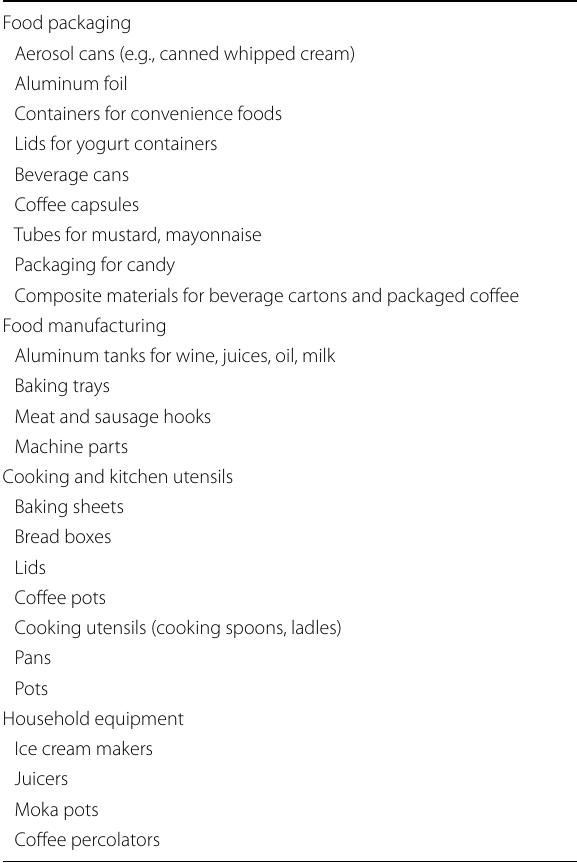
Table 5 Summary of food contact materials made of alu- minum. Source selection from [22] Food packaging Aerosol cans (e.g., canned whipped